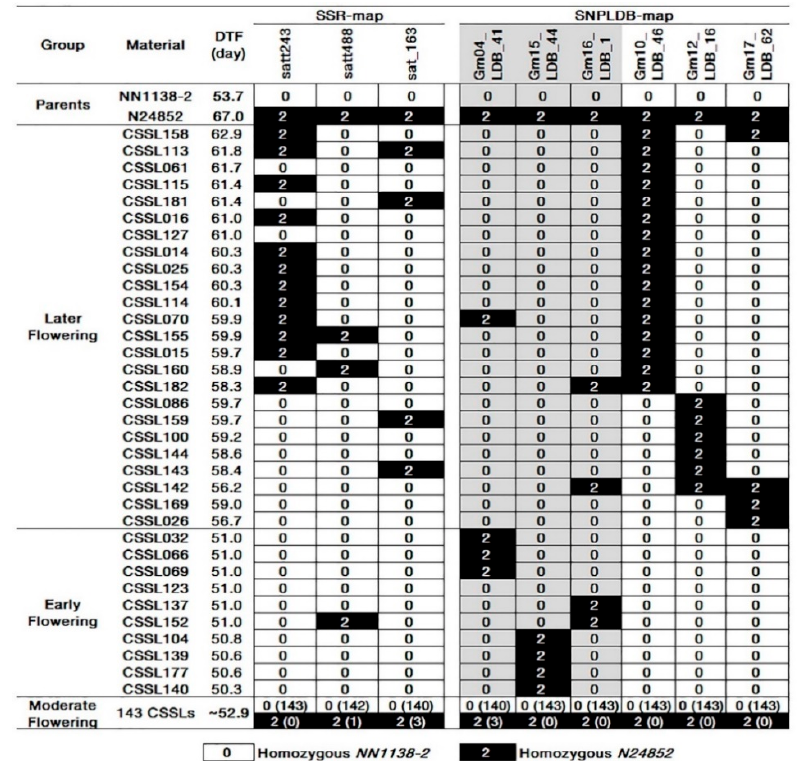
Figure 3. Joint comparisons of CSSLs significantly different from NN1138-2 in DTF. DTF, days to flowering. SSR-map, the physical map constructed with SSR markers; SNPLDB-map, the physical map constructed with SNPLDB markers. The wild segments on the markers in gray cells are of negative additive effects; the others are of positive additive effects. In 0(143), 0 represents NN1138-2 genotype while (143) represents 143 CSSLs with genotype 0 in intermediate flowering group. Similarly, 2(3) represents 3 CSSLs with genotype 2 (N24852) in intermediate flowering group.